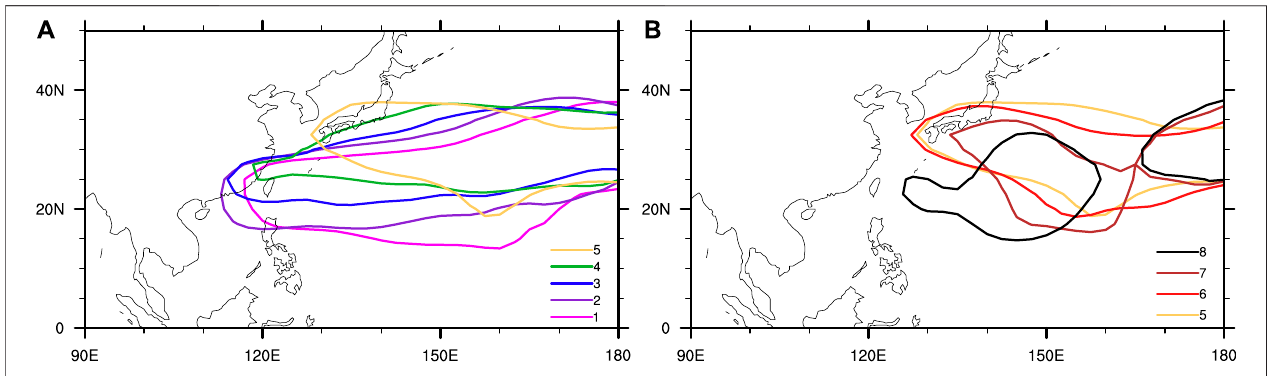
FIGURE 2 | The composites WPSH represented by 5,880 geopotential meter (gpm) at 500 hPa under phase 1 – 5 (A) and phase 5 – 8 (B) of WPSH_SMI_10-30d.